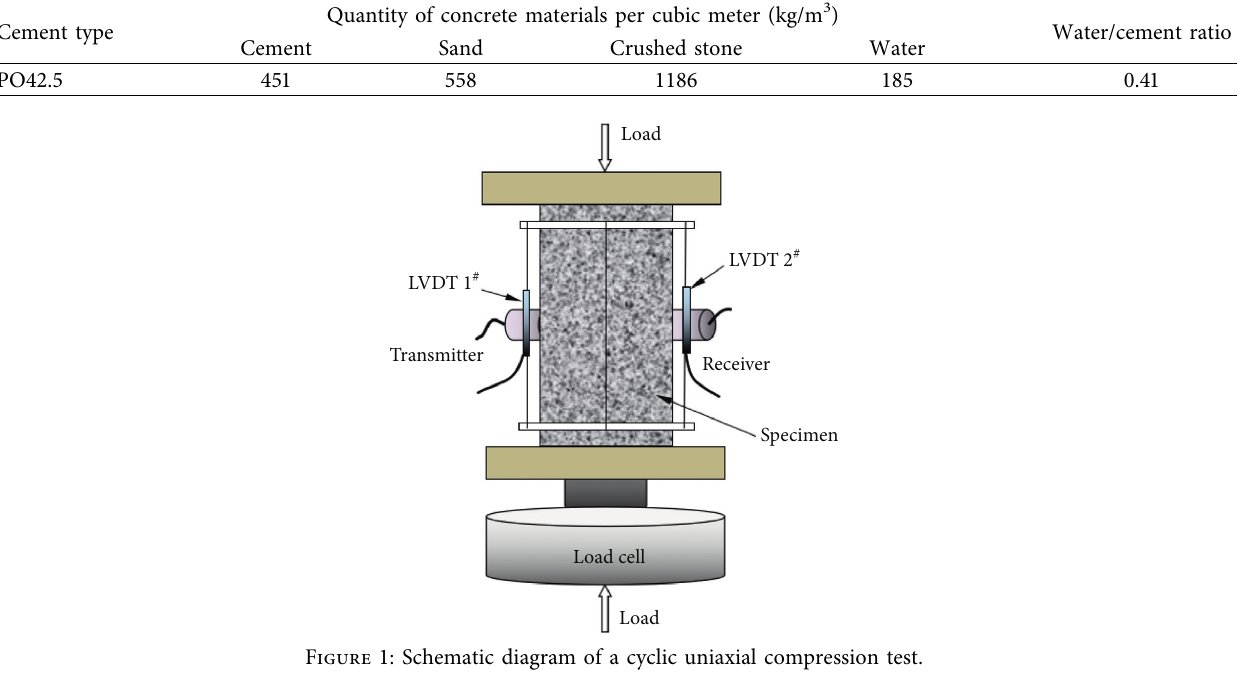
Table 1: Mix proportion of concrete samples.